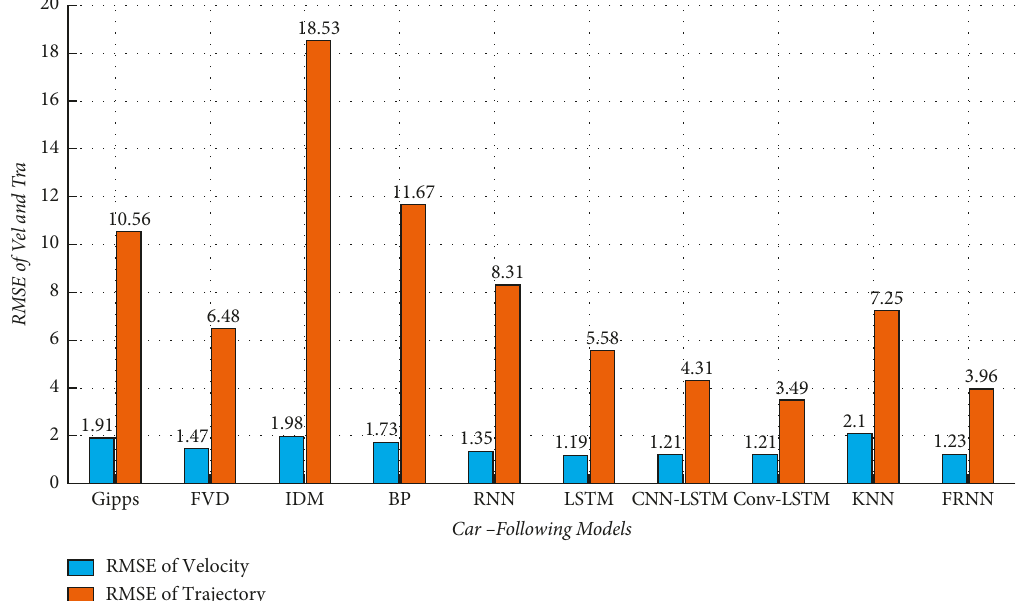
Figure 14: RMSE of conventional models and data-driven models in the continuous traffic flow. (ANN